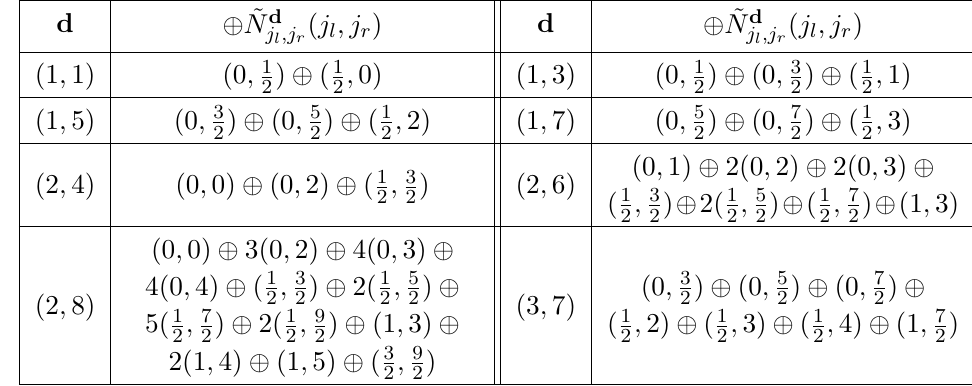
Table 4 . Spectrum of the adjoint Wilson loop operator in the SU(2) π theory for d 1 ≤ 3 and d 2 ≤ 8